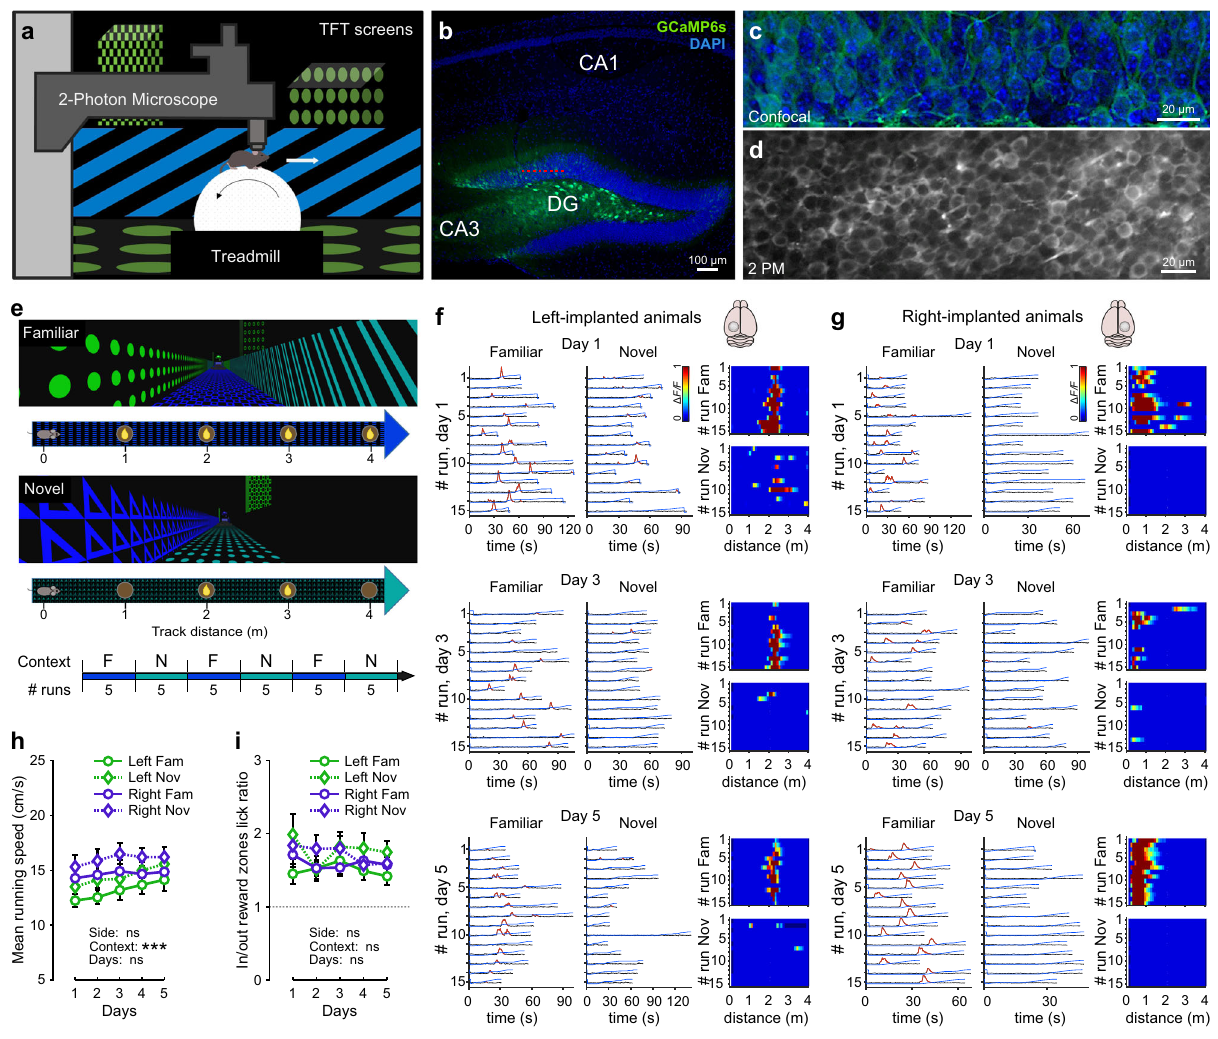
Fig. 1 | Two-photon calcium imaging of DG granule cells activity from either left- or right-implanted mice navigating through familiar and novel virtual environments.a Experimentalschematicofourvirtualrealitysetupforhead- fi xed mice. b Confocal image showing GCaMP6s-labeled neurons in the DG (green), tissue counterstained with DAPI (blue). Red dotted line indicates a typical imaging planeinthegranulecell(GC)layer. c ConfocalimageshowingGCaMP6slabelingof GCs intheDG. d Average fl uorescenceof GCaMP6ssignalsofGCsrecorded invivo using 2-photon microscopy imaging. e Top, schematic of familiar and novel 4m- long virtual environments. Yellow drops indicate the locations of soymilk rewards. Bottom, timeline of a recording session. a – e In all, 21 mice implanted either in the left ( n =11) or right ( n =10) hemisphere were used. Most animals were recorded twice, using two different novel environments, for a total of 36 datasets ( n left =18, n right =18; see also Supplementary Figs. 1 and 9). f Left panels, raw calcium traces (gray)withsigni fi canttransients(red)andlineartrackposition(blue)overtimeofa